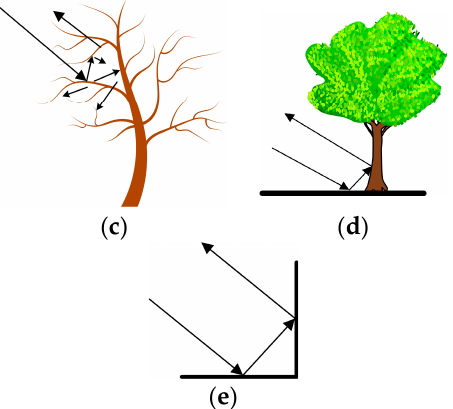
Figure 3. Basic physical radar backscattering mechanisms: ( a , b ) single surface backscattering, ( c ) volume, and ( d , e ) double dihedral.